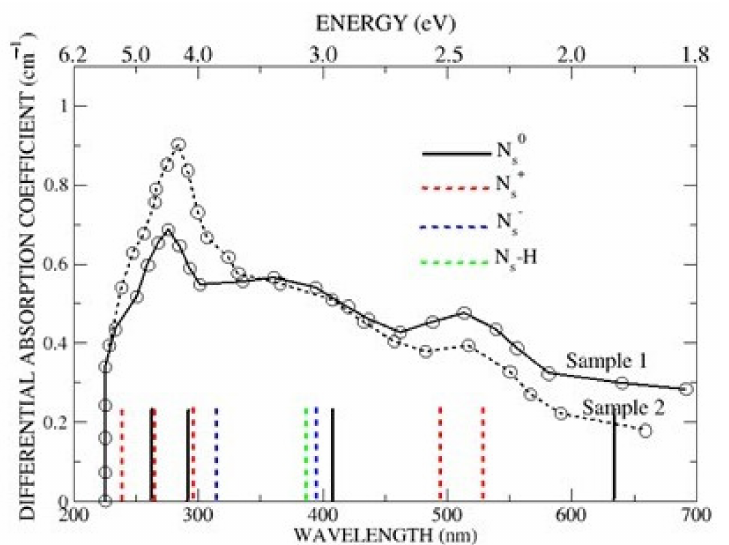
Figure 3. Comparison of the predicted ∆ -SCF Γ -point excitation energies in N s0 (black), N s+ (red), N s − (blue) and N s -H (green) with the optical spectra reported in Figure 4, Khan et al. [12]. (The heights of the vertical lines are